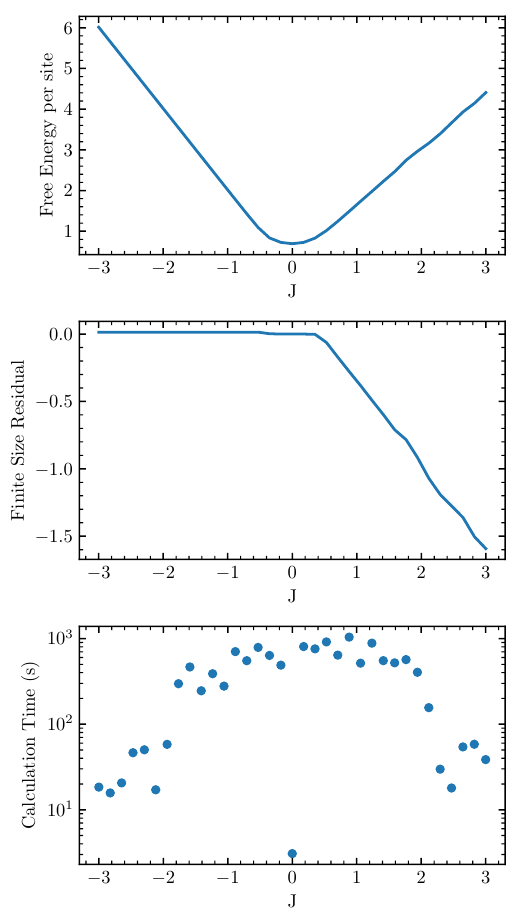
Figure 26: The free energy per site from PyTNR (top), residual versus the asymptotic value (middle) and computation time (bottom) for the 2D Ising model on a square lattice with periodic boundary conditions for h = 0 and as a function of J for a 7 × 7 lattice.